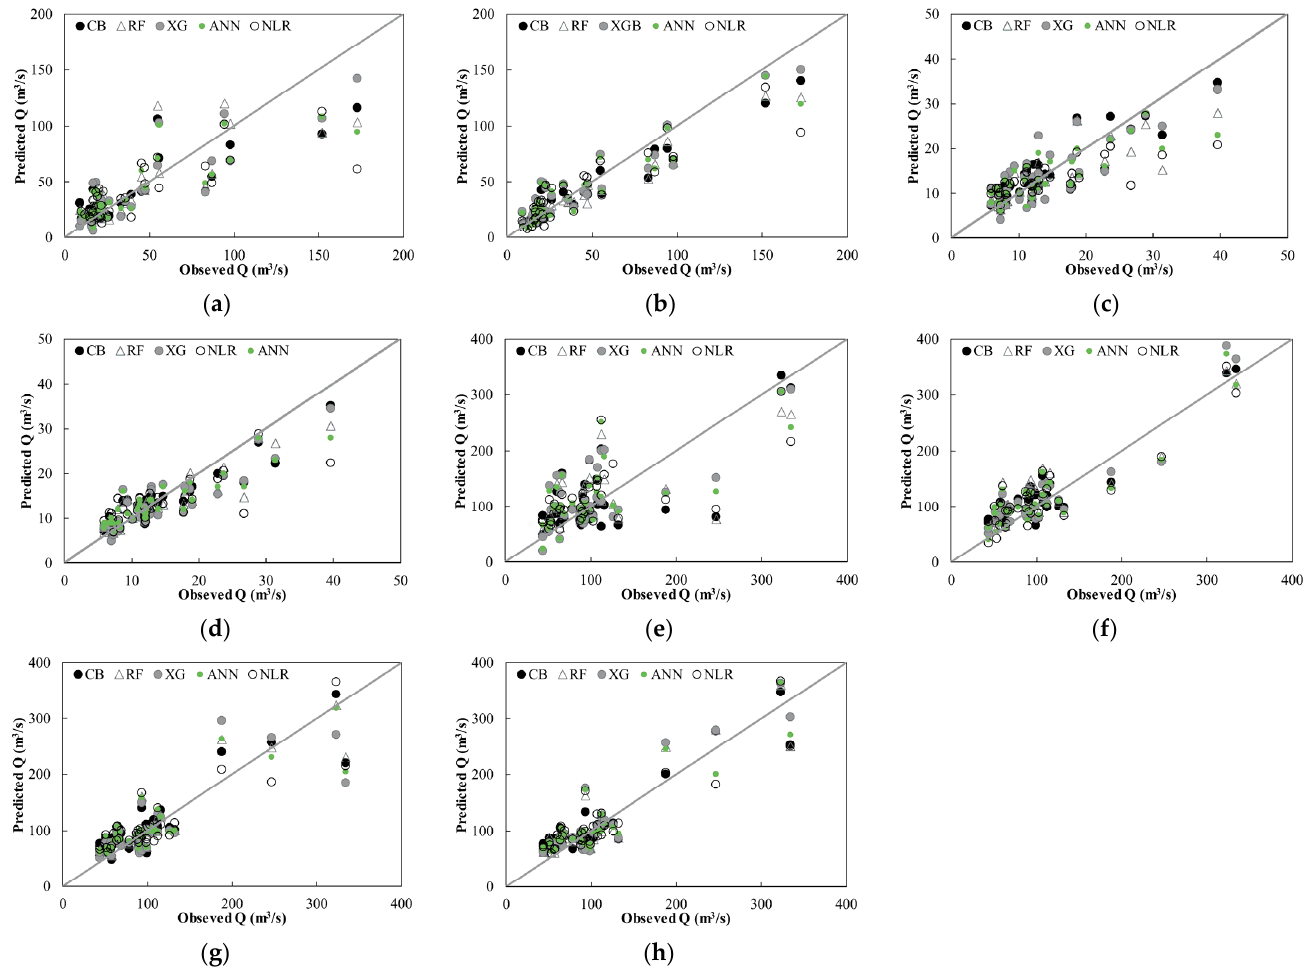
Figure 5. Scatter plots for ( a ) Durucasu (S 1 M), ( b ) Durucasu (S 1 MP) ( c ) Sutluce (S 1 M), ( d ) Sutluce (S 1 MP), ( e ) Kale (S 1 M), ( f ) Kale (S 1 MP), ( g ) Kale (S 1413 M) and ( h ) Kale (S 1413 MP).